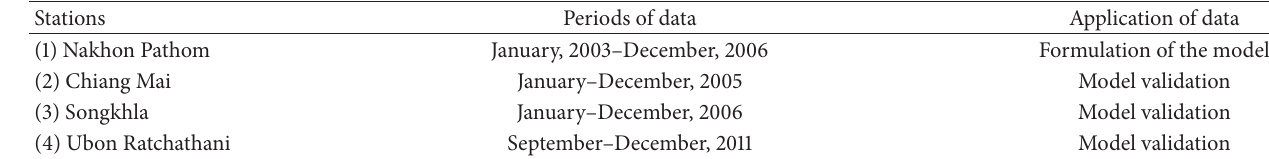
Table 1: The periods of sky luminance data used in this